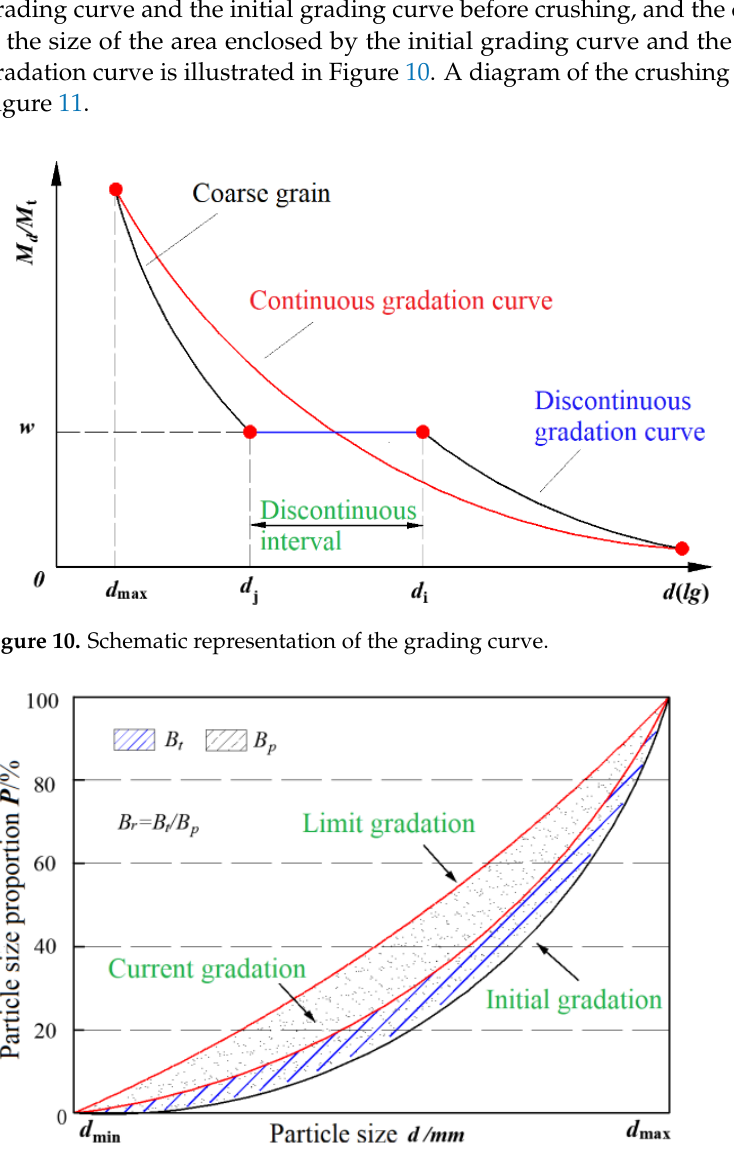
Figure 11. Representation of the degree of fragmentation.